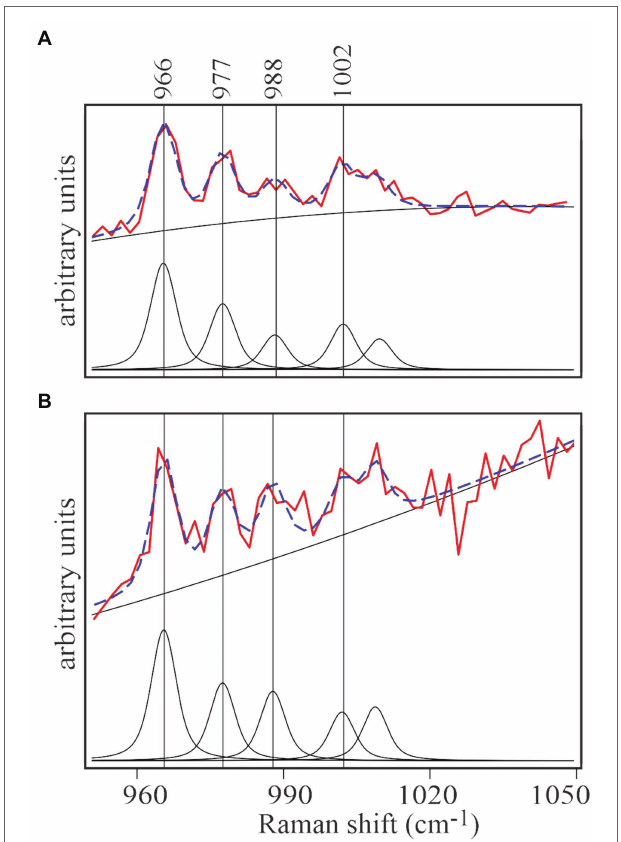
FIGURE 4 | Curve-fitting analysis of isotopic signatures of 13 C enriched E. huxleyi cells (A) and the EhV-163 released from them (B) . Both panels represent the averaged spectral region including the four characteristic Phe isotopologue peaks of 13 C-enriched E.huxleyi and EhV-163 presented in Figure 3C . After baseline correction and normalization, contribution of each isotopologue was determined by curve deconvolution and peak fitting (lower spectrum in each panel). Fitting results of the isotopologue distribution are illustrated by the broken blue lines superimposed on the actual observations (red spectrum in each